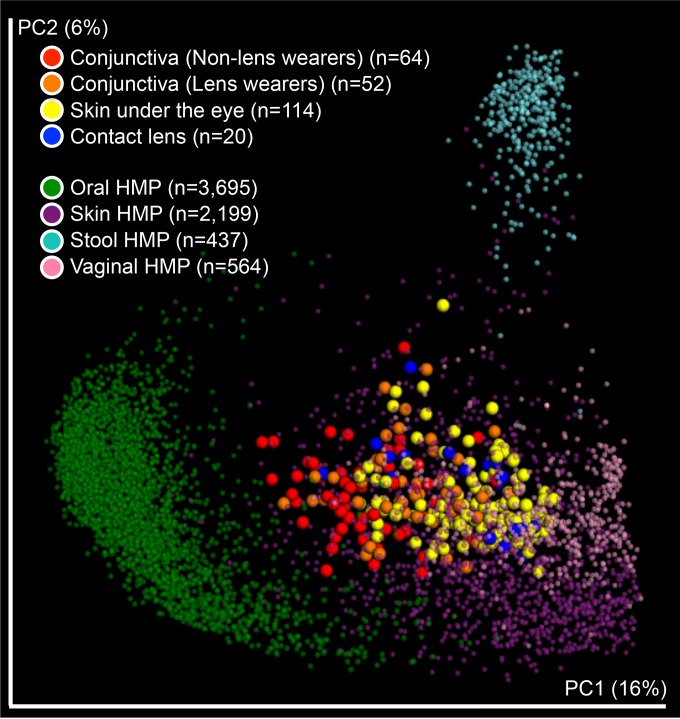
Beta diversity in conjunctiva, skin, and contact lens samples with samples from the HMP database. A PCoA plot was generated using unweighted UniFrac distances. Small dots (green, purple, cyan, and pink) indicate samples from the HMP database, and large dots (red, orange, yellow, and blue) indicate samples from this study.